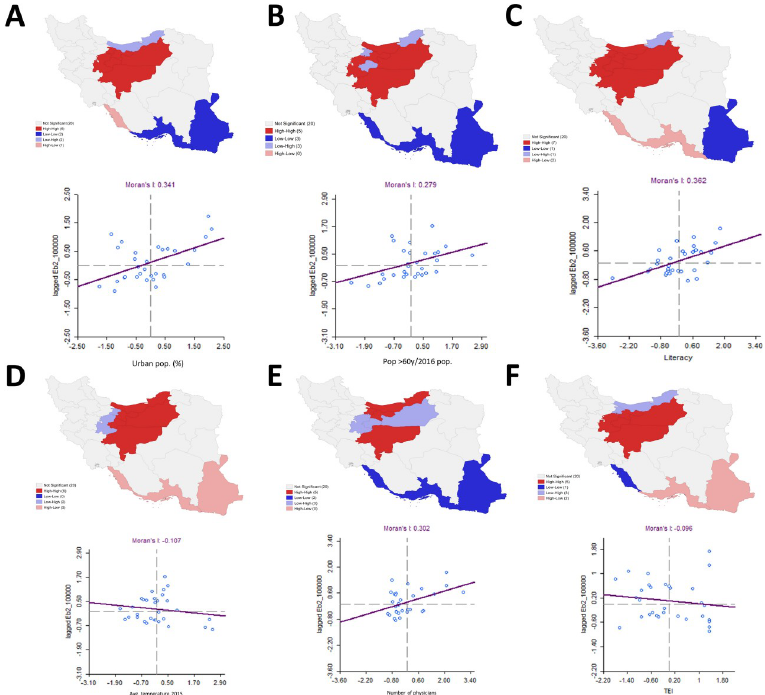
Fig 4. Bivariate LISA’s significant spatial clustering between each of the significant variables in the spatial lag model and the rate of cases with COVID-19 smoothed through the empirical Bayes approach. The scatter plots associated with the variables vs. the spatially lagged smoothed rate of COVID-19 cases are presented as well, including the associated linear regression fitting, whose slope corresponds to the bivariate Moran’s I statistic, a global spatial bivariate autocorrelation measure. A) People settled in urban areas in 2016 (%). B) People aged � 60 years, rates obtained through empirical Bayes smoothing. C) Literacy of population aged � 6 years in 2016 (%). D) Average temperature (˚C) of provincial capitals in 2015. E) Number of physicians employed by the ministry of health and medical education in 2006. F) Transportation Efficiency Index (TEI). Shapefiles obtained from the Stanford Libraries Earthworks: